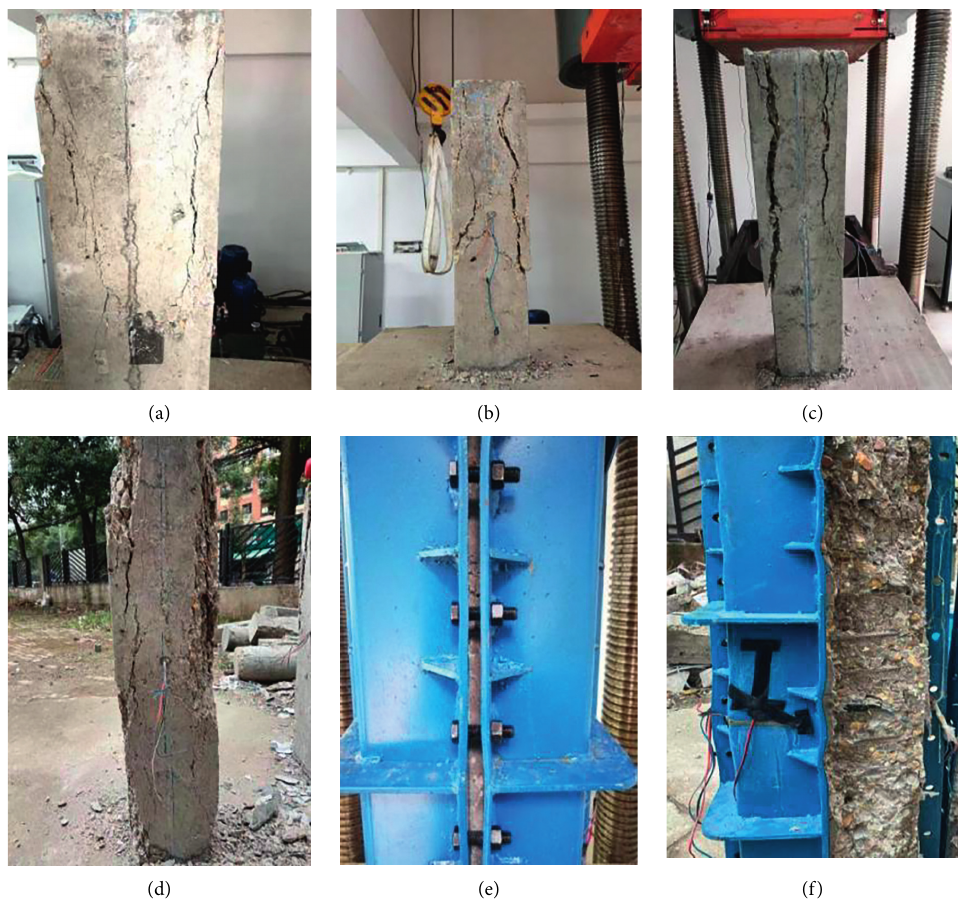
Figure 6: Failure modes of typical specimens. (a) CC-2. (b) RC0-1. (c) RC2-2. (d) RC3-1. (e) RC2-2. (f)